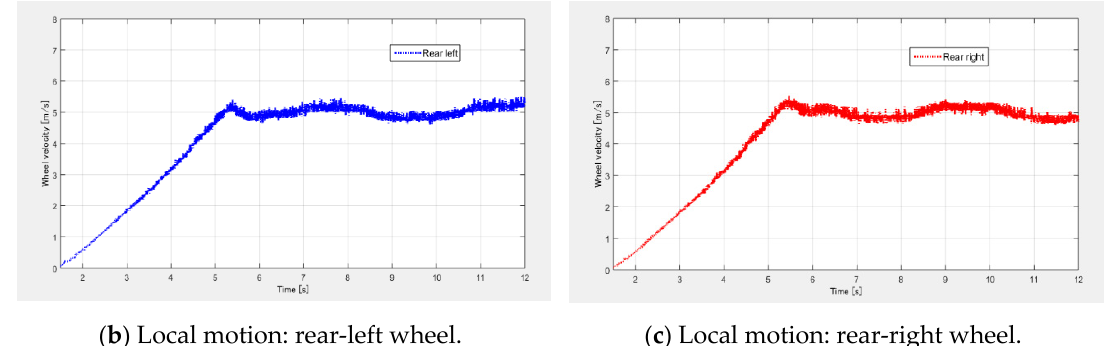
( b ) Local motion: rear-left wheel. ( c ) Local motion: rear-right wheel. Figure A3. Experiments of wheel velocity control using electric vehicle COMS.